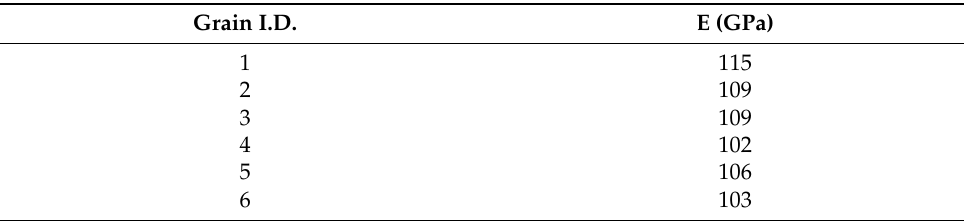
Table 2. Elastic modulus from six individual grains measured by strain gauge. Grain I.D.